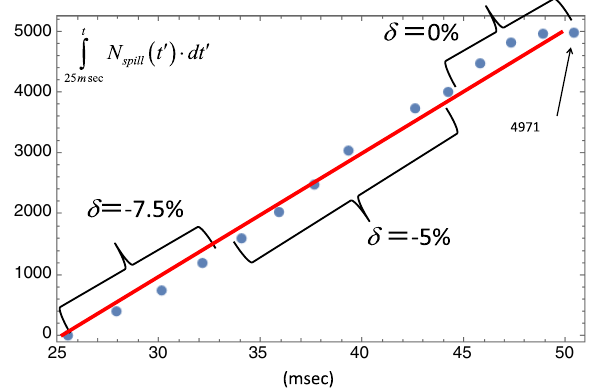
FIG. 15. Example of spill control for 5,000